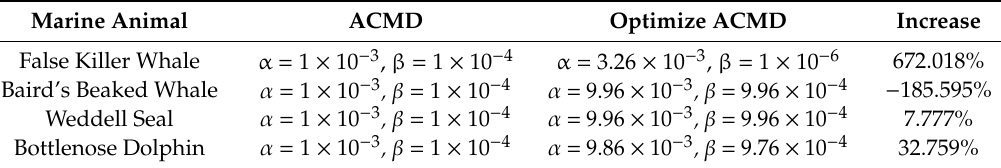
Figure 10. Optimized ACMD processing animal sound signals. ( a ) α = 3.26 × 10 − 3 , β = 1 × 10 − 6 , ( b ) α = 9.96 × 10 − 3 , β = 9.96 × 10 − 4 , ( c ) α = 9.96 × 10 − 3 , β = 9.96 × 10 − 4 , ( d ) α = 9.86 × 10 − 3 , β = 9.76 × 10 − 4 . Table 4. SNR changes before and after ACMD optimization.